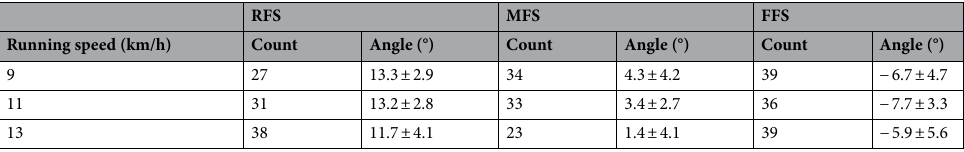
Table 1. Number of rearfoot (RFS), midfoot (MFS), and forefoot (FFS) strikers observed in the cohort of participants ( N = 100) and their corresponding foot-strike angles at three running speeds. The values are presented as the mean ± standard deviation.